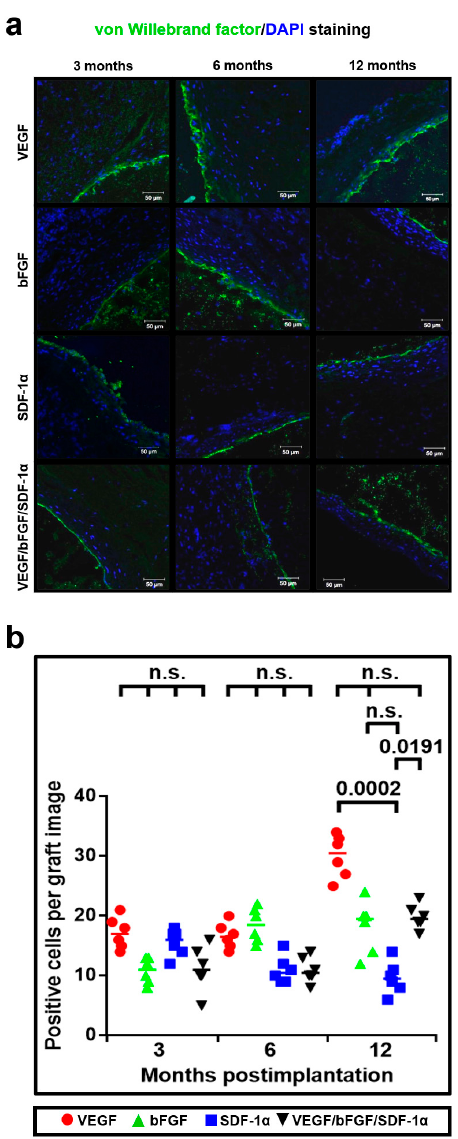
Figure 7. Either bFGF or SDF-1 α do not induce significant endothelialization of the luminal surface compared with VEGF. ( a ) Representative images of vWF- (green) and DAPI- (blue) stained grafts modified with either VEGF, bFGF, SDF-1 α , or all three factors at 3, 6, and 12 months postimplantation; ( b ) Quantitative image analysis, data are represented as a univariate scatterplot with the median, each dot represents a count from one image, Kruskal–Wallis test with the further Dunn’s multiple comparisons test, p values adjusted for multiple comparisons are reported in a numerical manner, n.s. is for not significant.